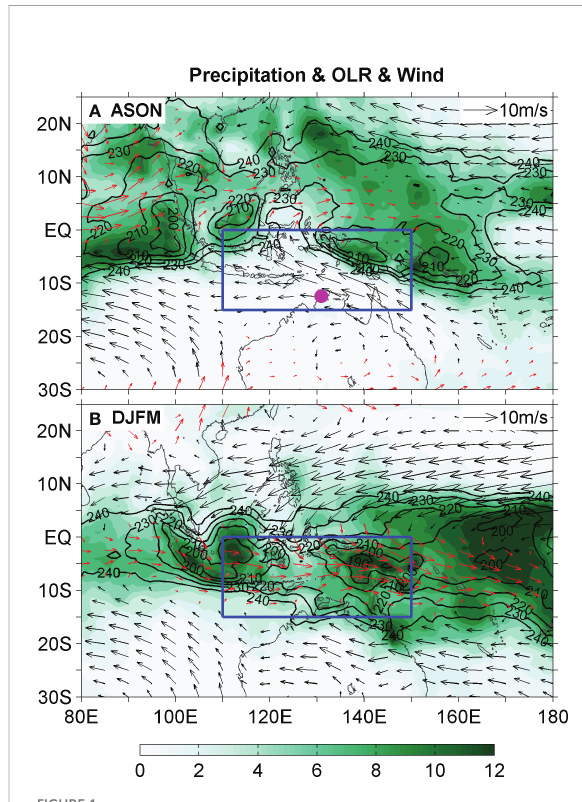
FIGURE 1 The seasonal patterns of the IAM system for (A) August – November 2018 and (B) December 2018 – March 2019: GPCP precipitation (shaded; mm day − 1 ), NOAA OLR (black contours; only values lower than 240 W m − 2 are shown), and ERA5 wind fi eld (vectors; m s − 1 ). The red (black) vectors indicate that the zonal component of the wind is westerly (easterly). The blue box (0° – 15°S, 110° – 150°E) superimposed on the plot indicates the region of the IAM system in the present study. The magenta dot in (A) indicates the Darwin airport station (station number: 14015), Australian Bureau of